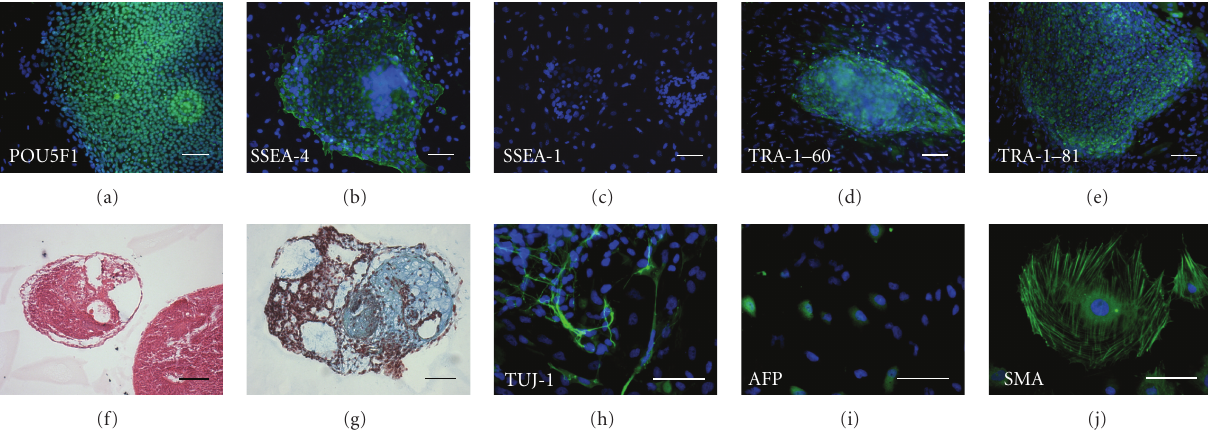
Figure 2: Characterization of CU1 hESC line. Immunohistochemical analysis with DAPI counterstain revealed that hESC colonies expressed pluripotency markers POU5F1/OCT4 (a), SSEA-4 (b), TRA1-60 (d), TRA-1-81 (e) (green fluorescence) and were negative for di ff erentiation marker SSEA-1 (c). hESC cultured as embryoid bodies di ff erentiated into all three germ layers. Hematoxylin and eosin (f), Masson’s trichrome (g), immunohistochemistry for neuron-specific beta-III tubulin (TUJ-1) (h), alpha fetoprotein (AFP) (i), and smooth muscle actin (SMA) (j) Scale bar = 100 µ